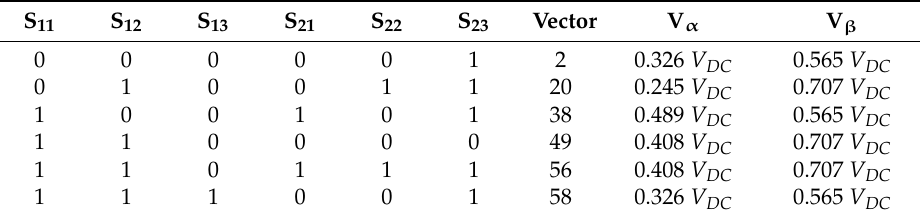
Table 3. Combination and applied voltage for V DC 1 = 0.8 V DC 2.